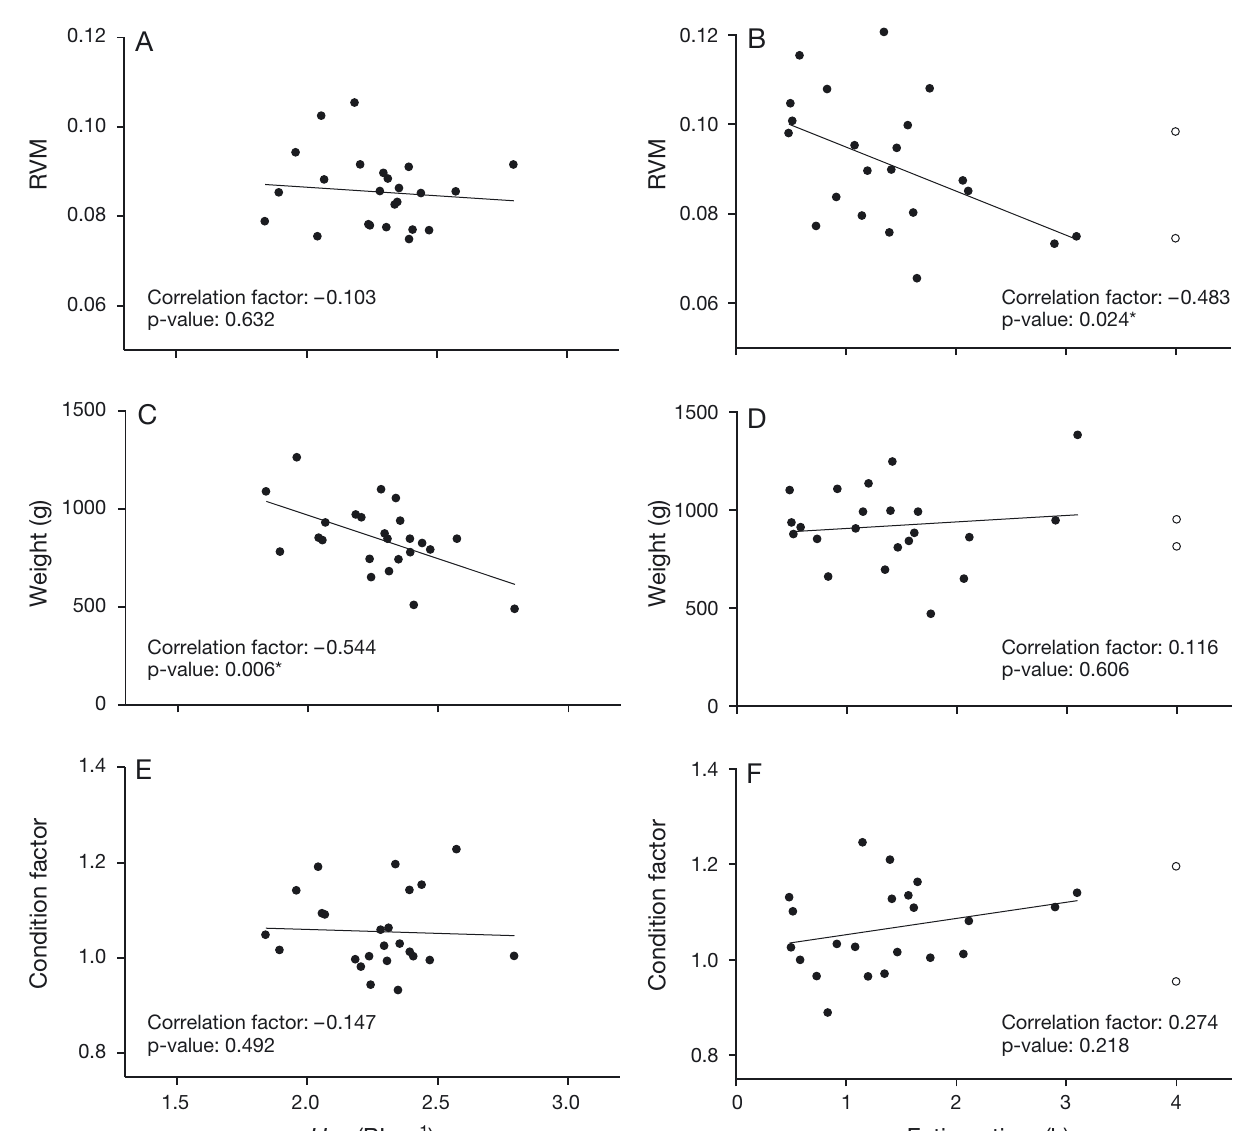
Fig. 4. Relative ventricular mass (RVM), weight, and condition factor versus either the relative critical swimming speed ( U crit ) (left panels) or fatigue time of Atlantic salmon during the sustained swimming challenge at 97 cm s −1 (right panels) (n = 24). Open circles on right panels: fish that completed the swimming trial and were therefore omitted from the correlation analyses. *p <